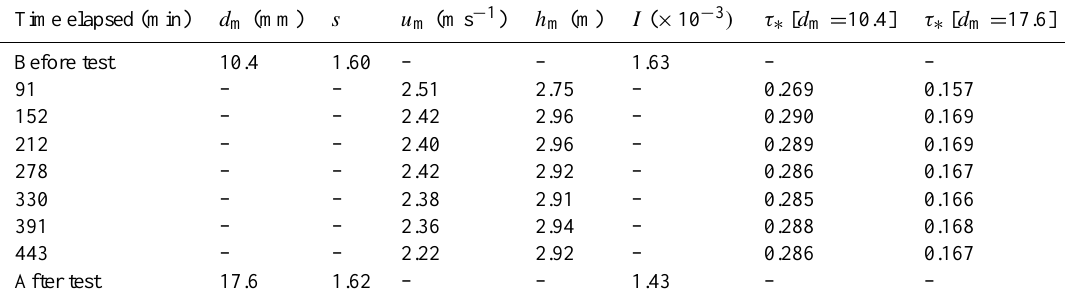
Table 2. Hydraulic values (Case 1).